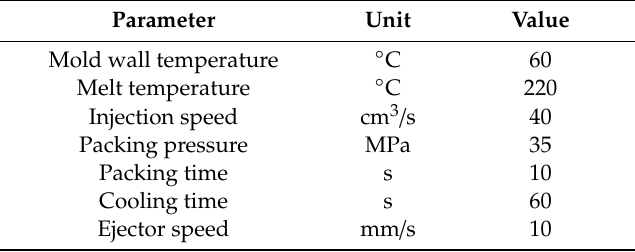
Table 1. Process parameters for the injection molding experiments.